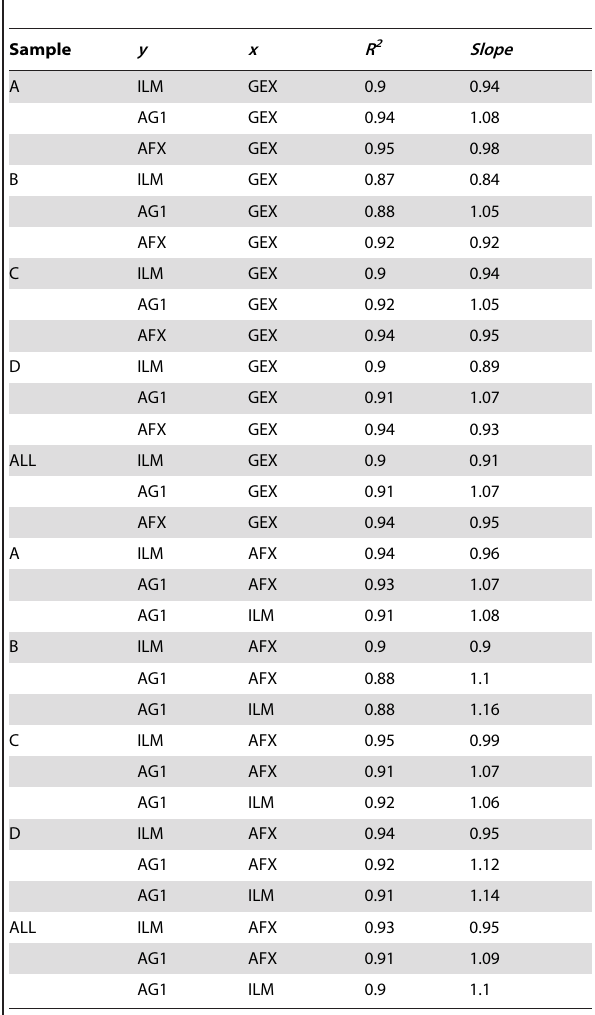
Table 1. Summary of GLAM predictions on the MAQC